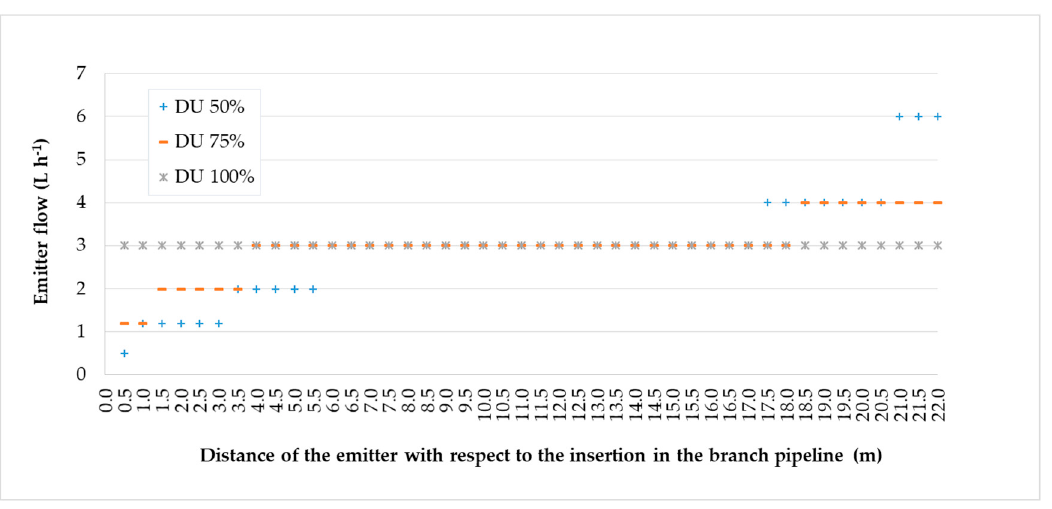
Figure 1. Diagram of the distribution of emitters and their flow rate in the drip pipeline for each of the uniformity distribution coefficient (DU) levels studied.